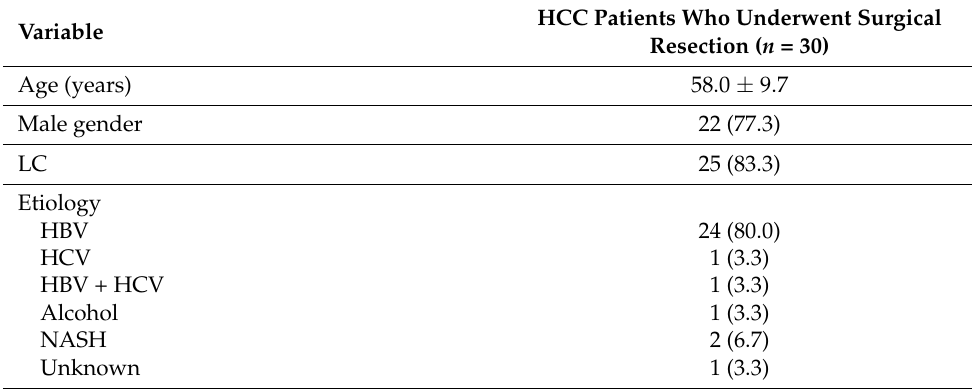
Table 1. Clinicopathologic characteristics and EMT markers of